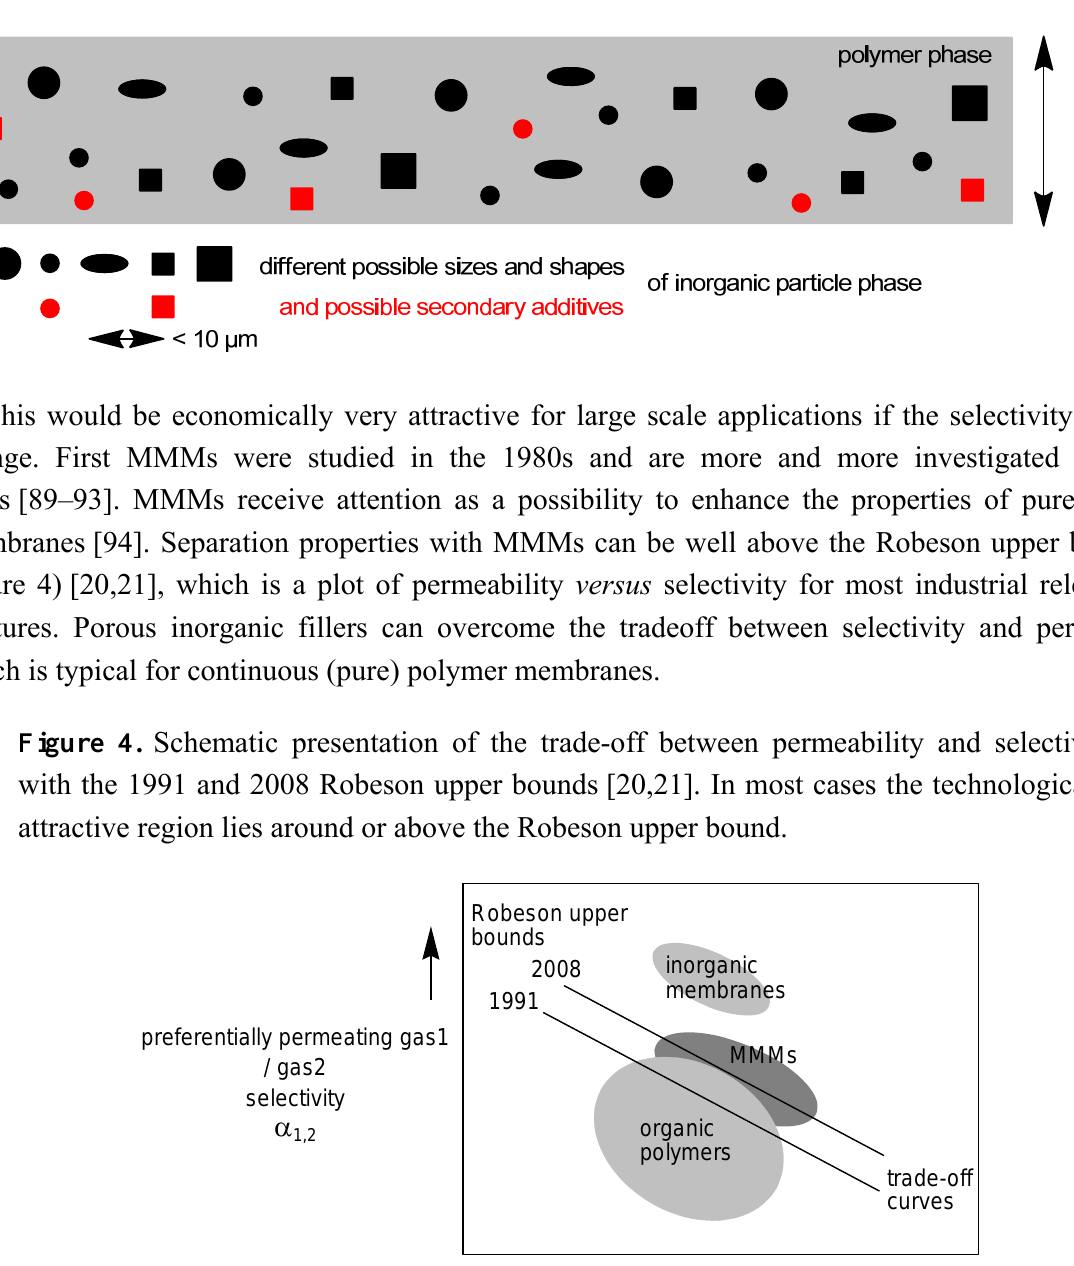
Figure 3. Schematic representation of a mixed-matrix membrane indicating the different possible sizes, shapes and components for the inorganic filler materials (e.g., MOFs, ZIFs and nanotubes).